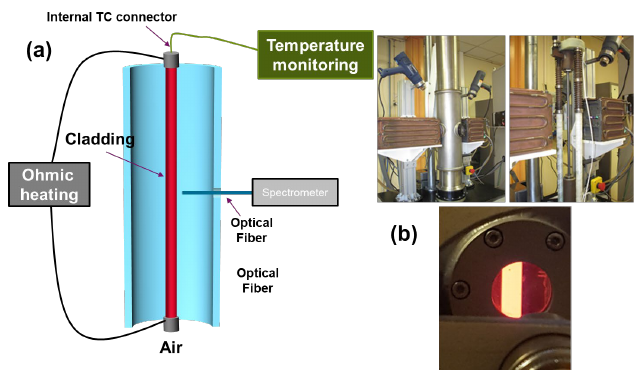
Figure 1.a Experimental setup for steam effect testing on the temperature measurement by IR pyrometry, b. Pictures of EDGAR test facility